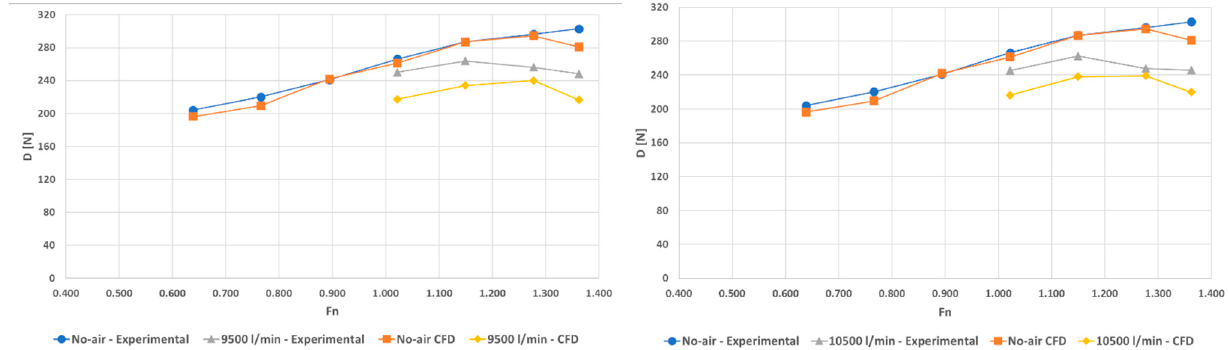
Figure 18. Experimental and CFD results to air injection 9500 L/min and 10,500 L/min.